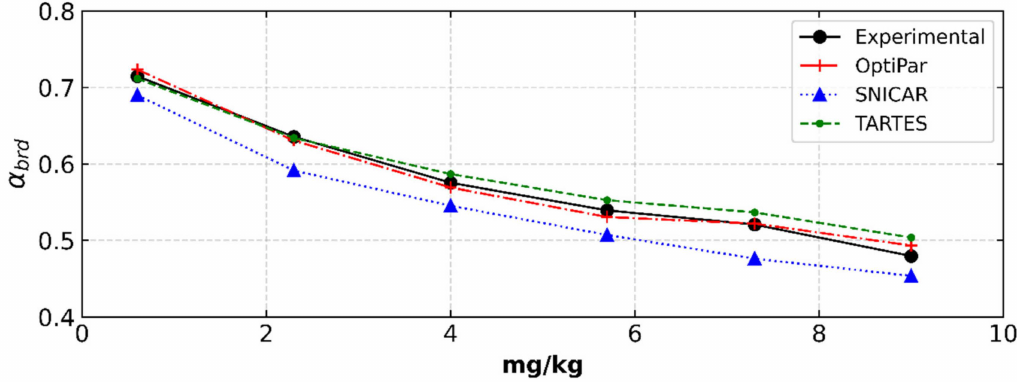
Figure 9. Experimental and modelled broadband albedo ( α brd